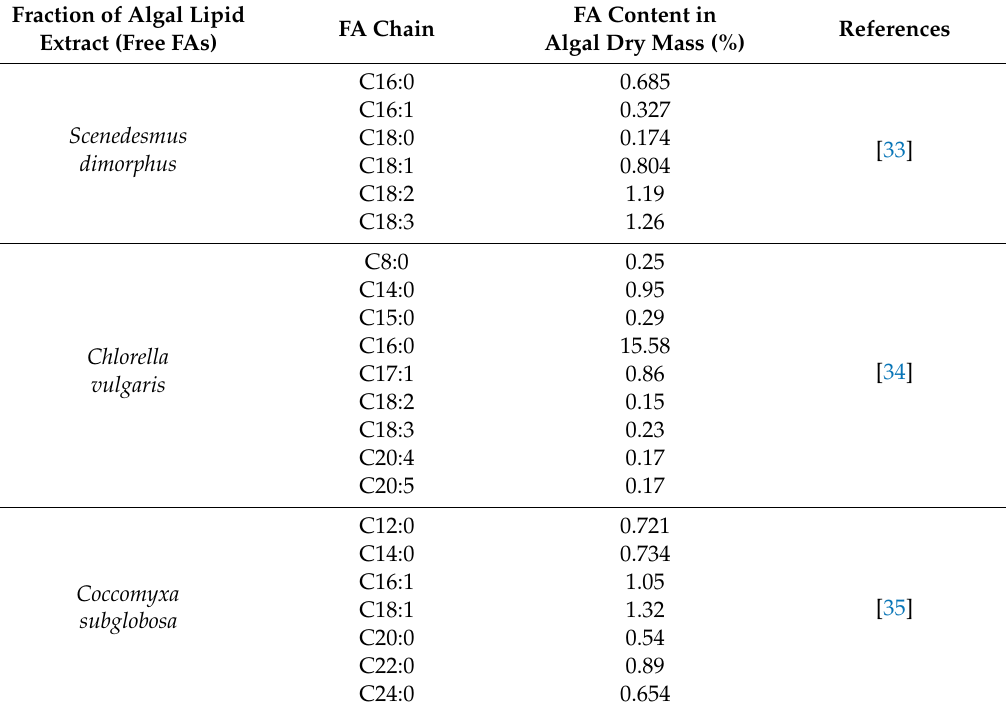
Table 3. FA content as FAMEs from FA fractions of algal lipid